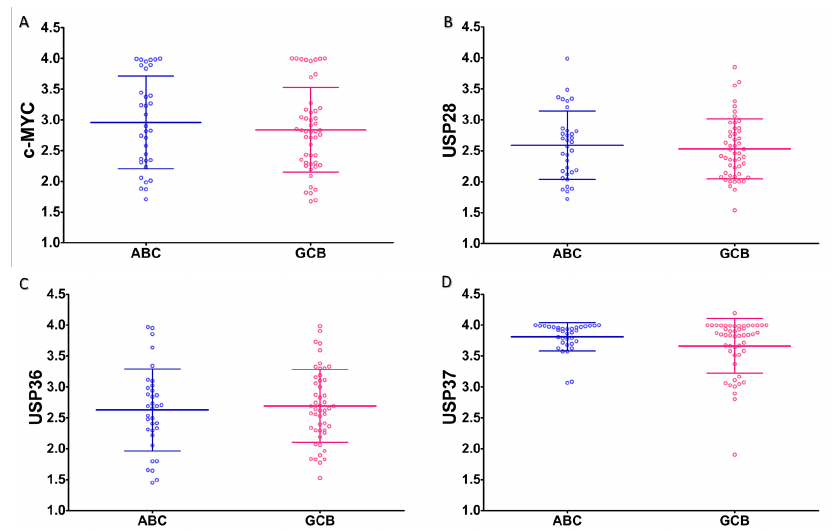
Figure 3. Expression of c-MYC and USPs in subtypes of DLBCL. Graphs showing expression (OD) of ( A ) c-MYC, ( B ) USP28, ( C ) USP36 and ( D ) USP37 in ABC (Blue) and GCB (Red) subtypes of DLBCL. Small and large horizontal lines represent mean and standard deviation, respectively.